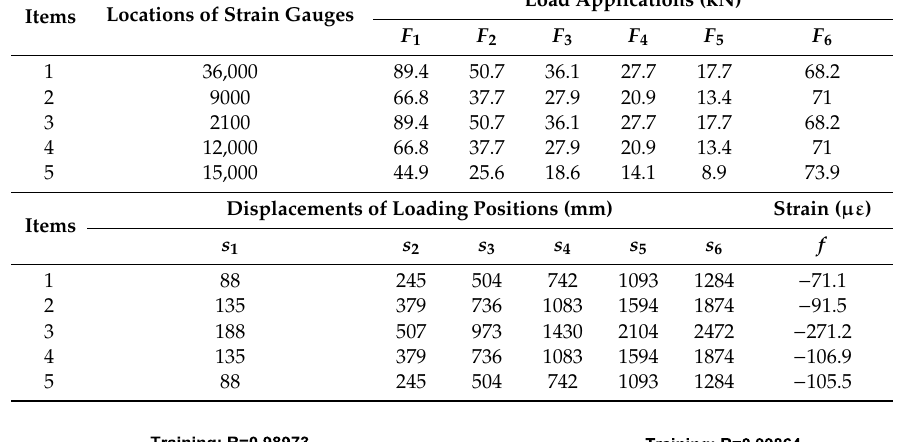
Table 6. The test samples used by BPNN and PSO-BPNN model.